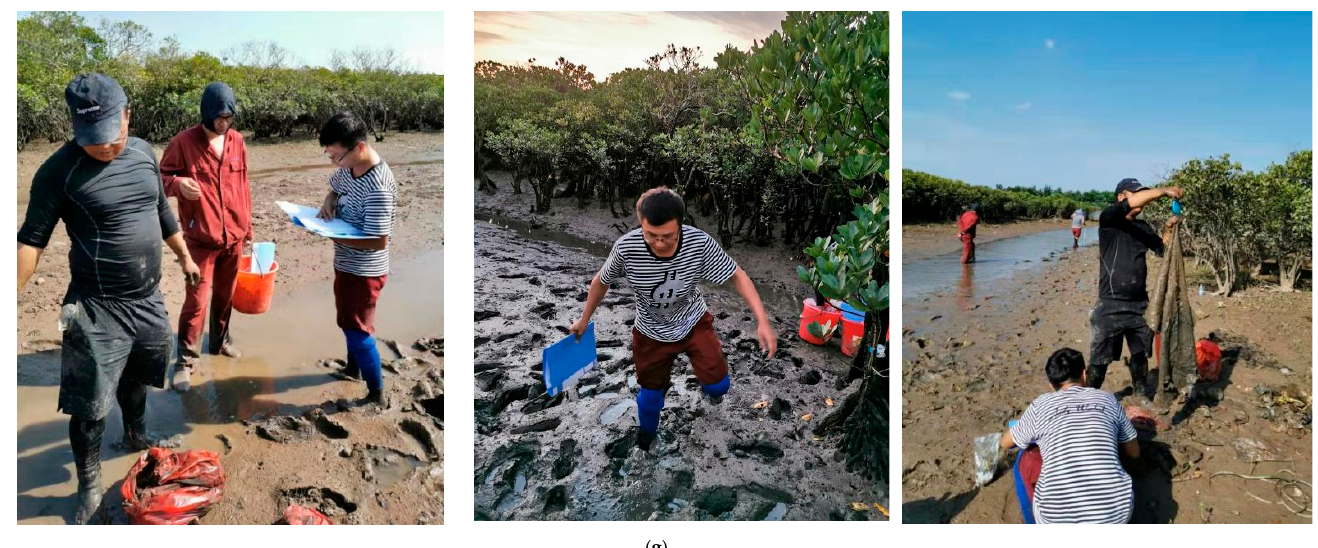
Figure 2. The in situ monitoring and collection of the debris in mangrove forest. ( a ) Plastic bag hung by the branch in Jiaodong; ( b ) Rope hung by branches in Jiaodong; ( c ) Plastic bag in the mud at Jiaodong; ( d ) Beverage boxes and used clothes at Rongshutou; ( e ) Styrofoam hung by the branch in Zhushan; ( f ) Electronic debris in Zhushan; ( g ) In situ collection of the debris.